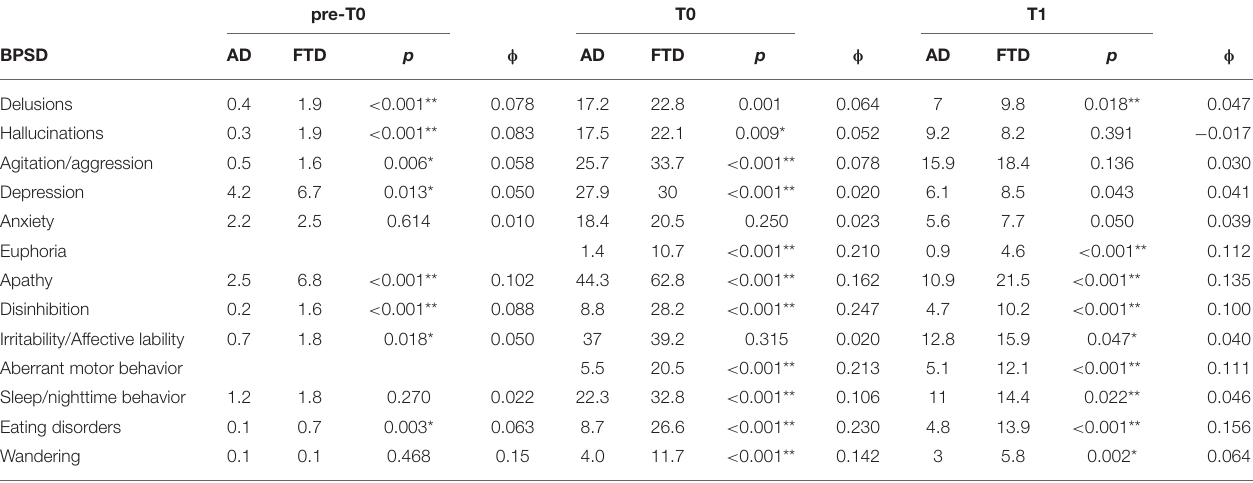
TABLE 3 | Prevalence of BPSD in AD and bvFTD groups divided by three